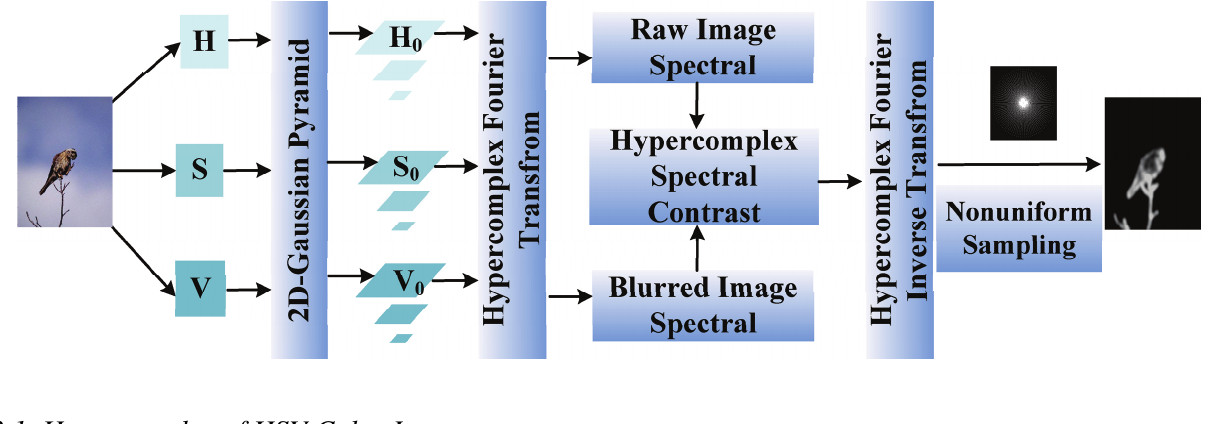
Figure 2. Overview of the HSC saliency perception